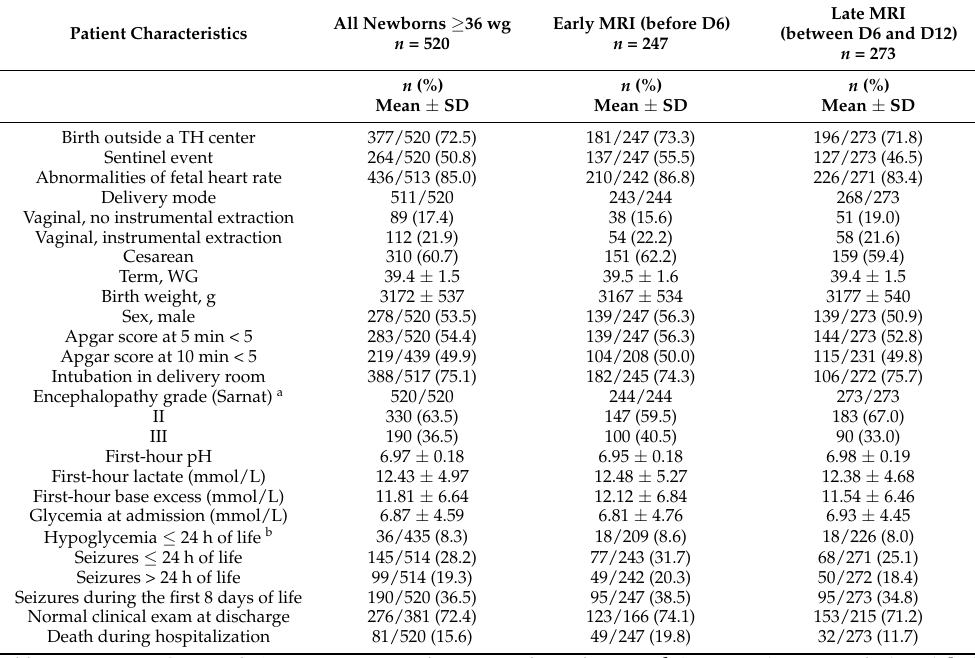
Table 3. Characteristics of the population according to the timing of